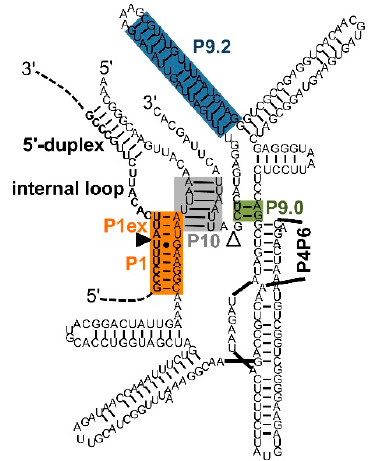
Figure 3. Secondary structure elements formed between extended guide sequence (EGS) and substrate [50,54]. Color-coding and the (non-physical) overlap of helices P1 extension and P10 are as described in Figure 1. The EGS is the ribozyme sequence 5 ′ -terminal of the G at the 5 ′ -splice site. The secondary structure elements formed between EGS and substrate are P1 extension, internal loop, and 5 ′ -duplex. The secondary structure element formed between EGS and the 3 ′ -exon of the ribozyme construct is the P10 helix. The secondary structure is that of a trans -splicing Tetrahymena ribozyme with an EGS optimized in a selection experiment [50]. The sequence of the 3 ′ -exon was modified to illustrate the P10 helix.